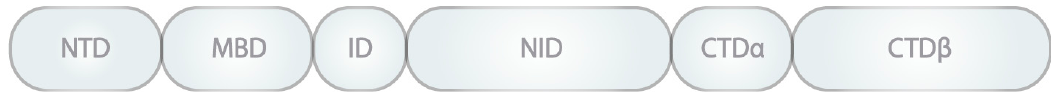
Figure 1. Schematic representation of the functional domains of methyl CpG binding protein 2 (MeCP2). MeCP2 contains an N -terminal domain (NTD), a methyl-binding domain (MBD), an intervening domain (ID), an NCoR-interacting domain (NID), and C -terminal domains α and β (CTD α and CTD β , respectively).